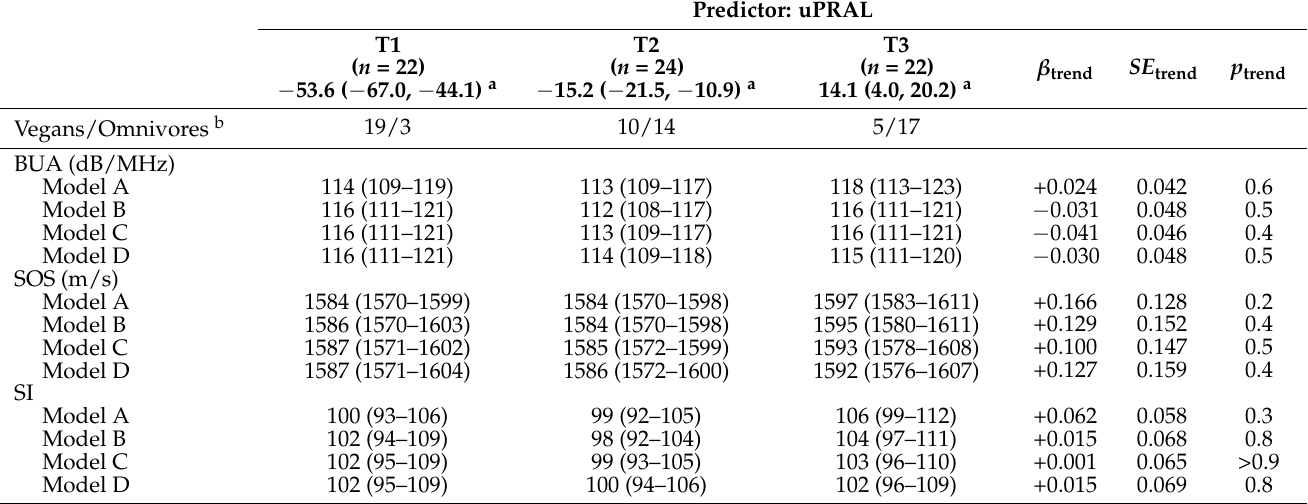
Table 2. Association of uPRAL with quantitative ultrasound parameters of bone health ( n = 68) presented as linear trends and least-squared means of bone health parameters in uPRAL